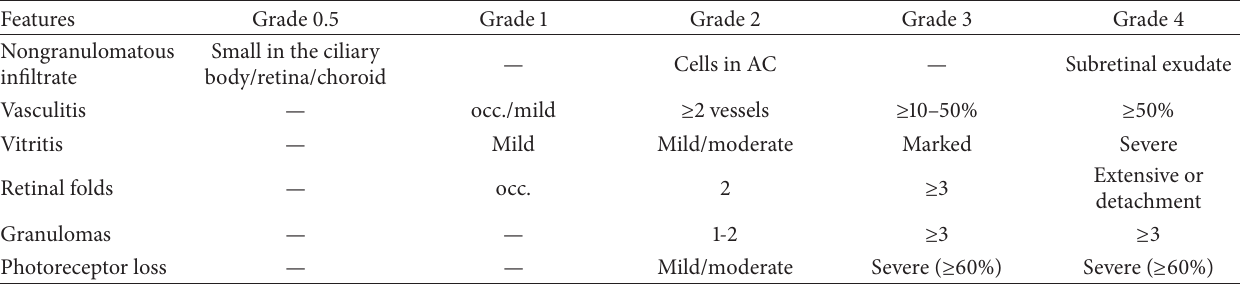
Table 2: Histopathological scoring